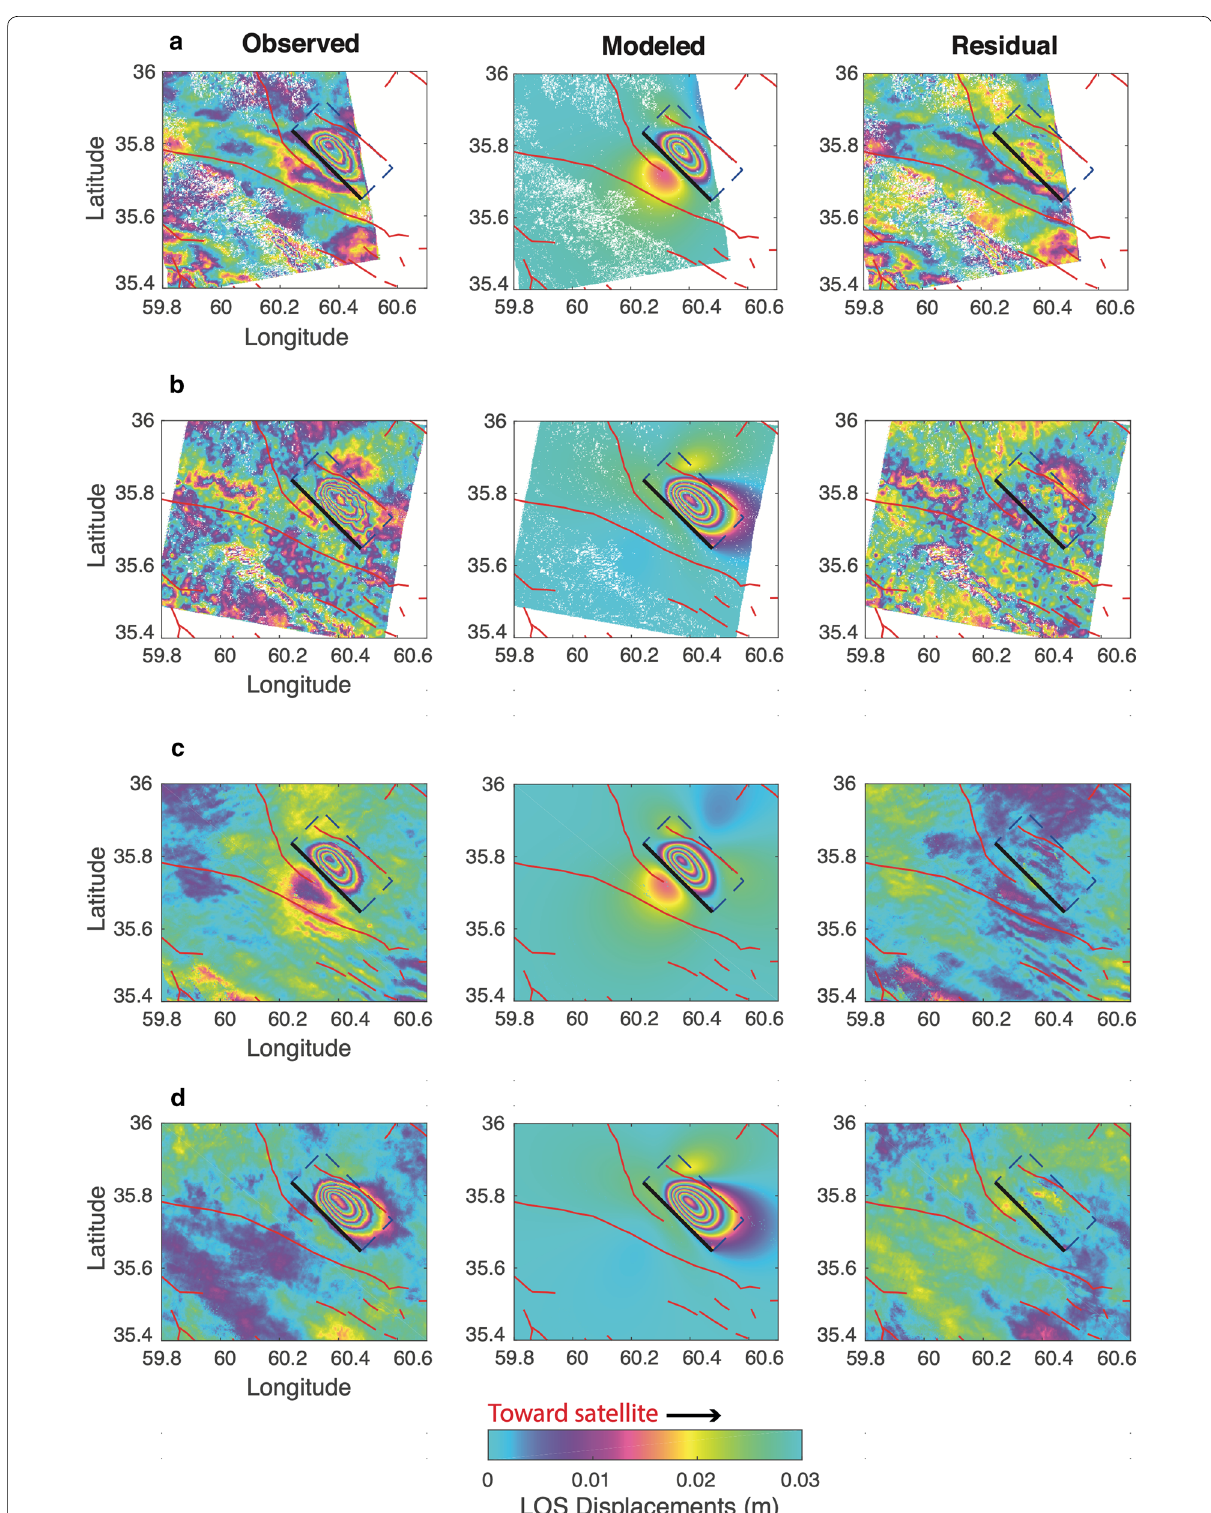
Fig. 8 Observed, modeled and residual interferograms for the northeast-dipping fault model (our preferred model). a , b ALOS-2 ascending and descending datasets, respectively. c , d Sentinel-1A ascending and descending datasets,